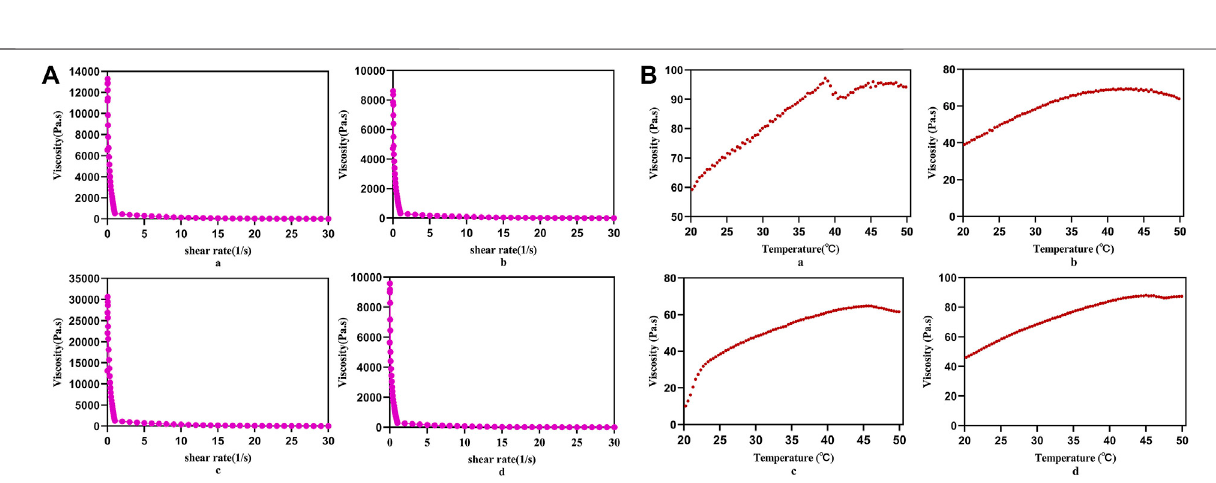
Frontiers in Bioengineering and Biotechnology |